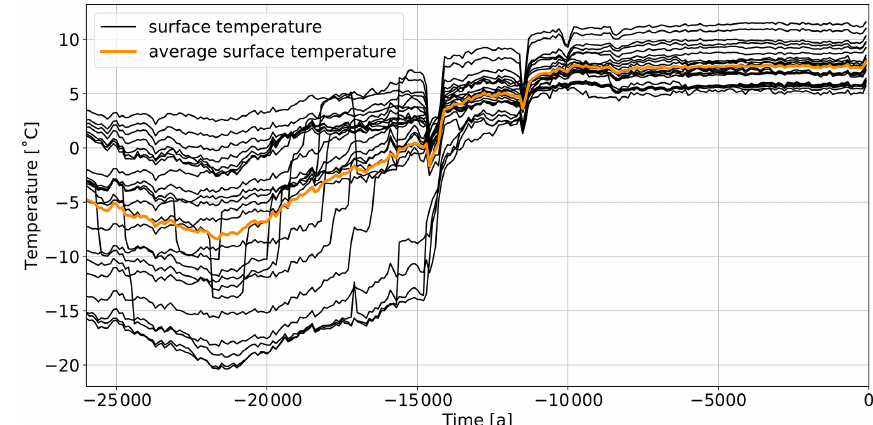
Figure 7. Paleotemperature reconstruction for all reconstruction points inside the CEBS model (denoted in black). Furthermore, we plot the average of all data points in orange.